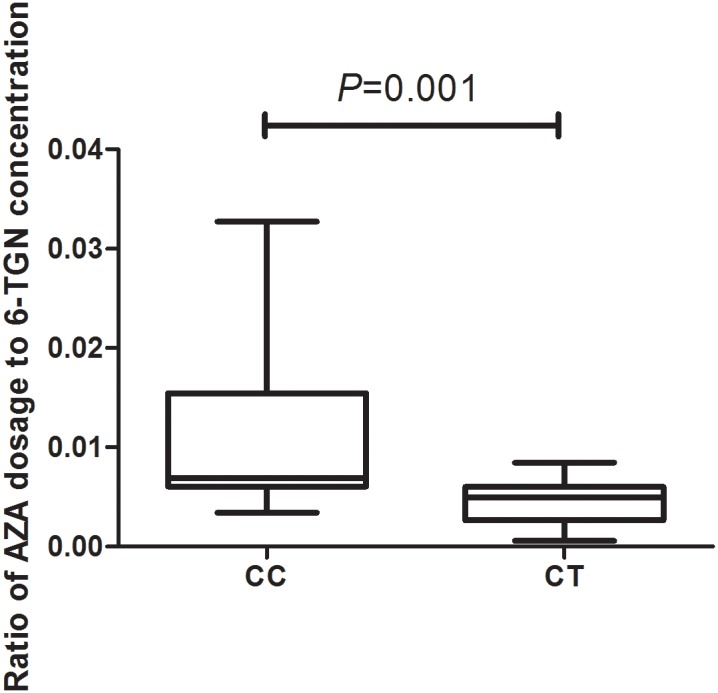
The median ratio of thiopurine dose to 6-TGN concentration for the patients with rs116855232 CC and CT genotypes were 0.007(0.006, 0.015) and 0.005(0.003, 0.006; P = 0.001).